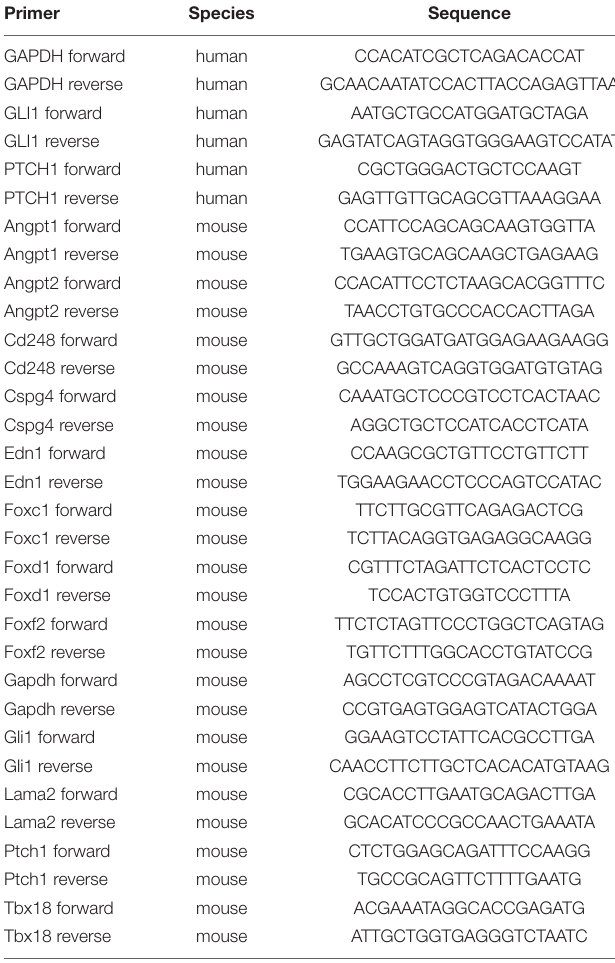
TABLE 1 | Primer sequences used for